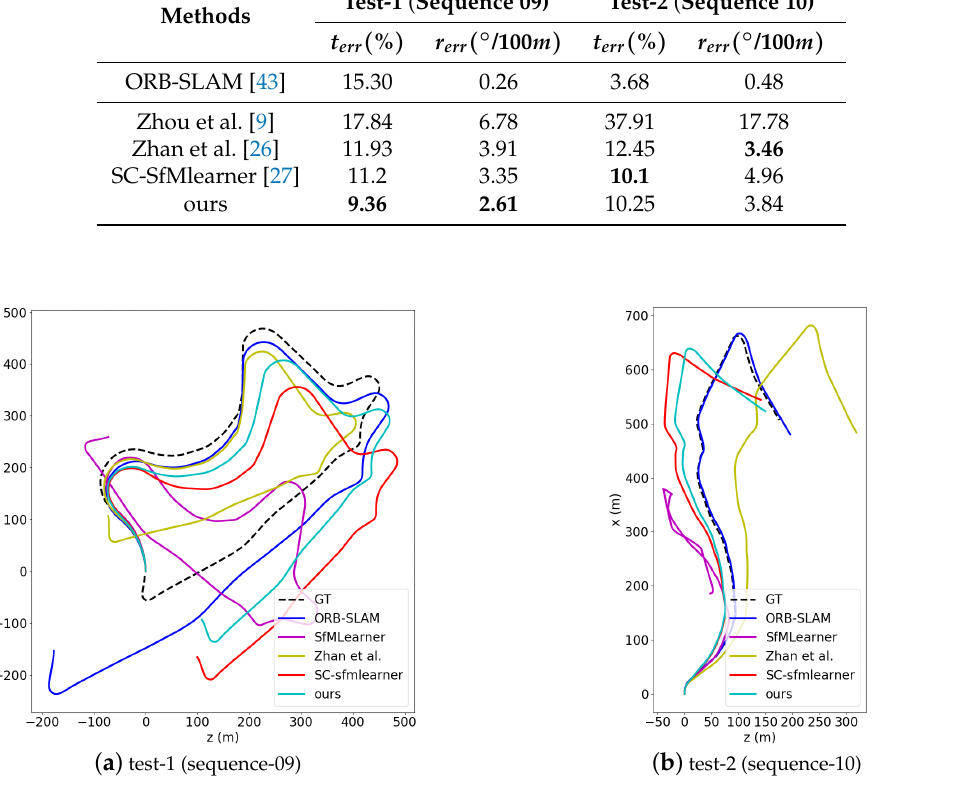
Figure 7. Qualitative results on the KITTI odometry test set. ( a ) is the result on test-1, ( b ) is the result on test-2. In comparison with unsupervised methods, our estimated trajectory is relatively closer to the GT in both